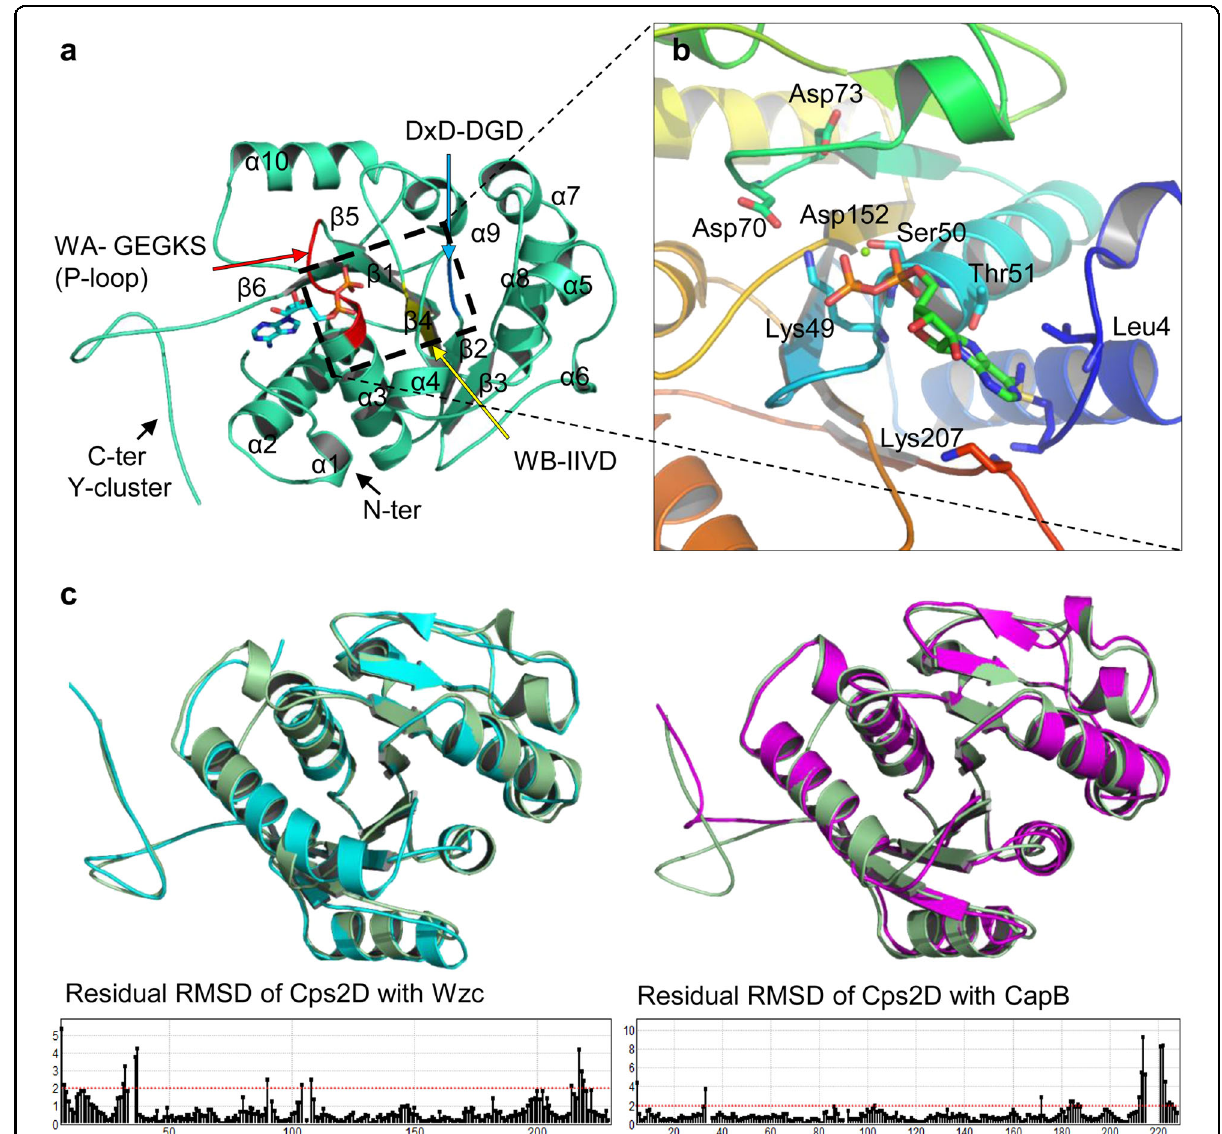
Fig. 6 Structural analysis of Cps2D. a 3D model of Cps2D exhibiting typical BY-kinase-like structure. The red loop highlights the Walker A (WA) motif containing ATP-binding conserved residues and the p-loop ( α 2 – β 1). The cyan color indicates the catalytic DxD motif, and the yellow color marks the Walker B (WB) motif. These motifs are essential for the enzymatic activity of tyrosine kinases. b The ADP-bound active site of Cps2D with the conserved L49 and DxD catalytic domain. c Our Cps2D model superimposed over previously reported crystal structures of tyrosine kinase from E. coli (Wzc) and S. aureus